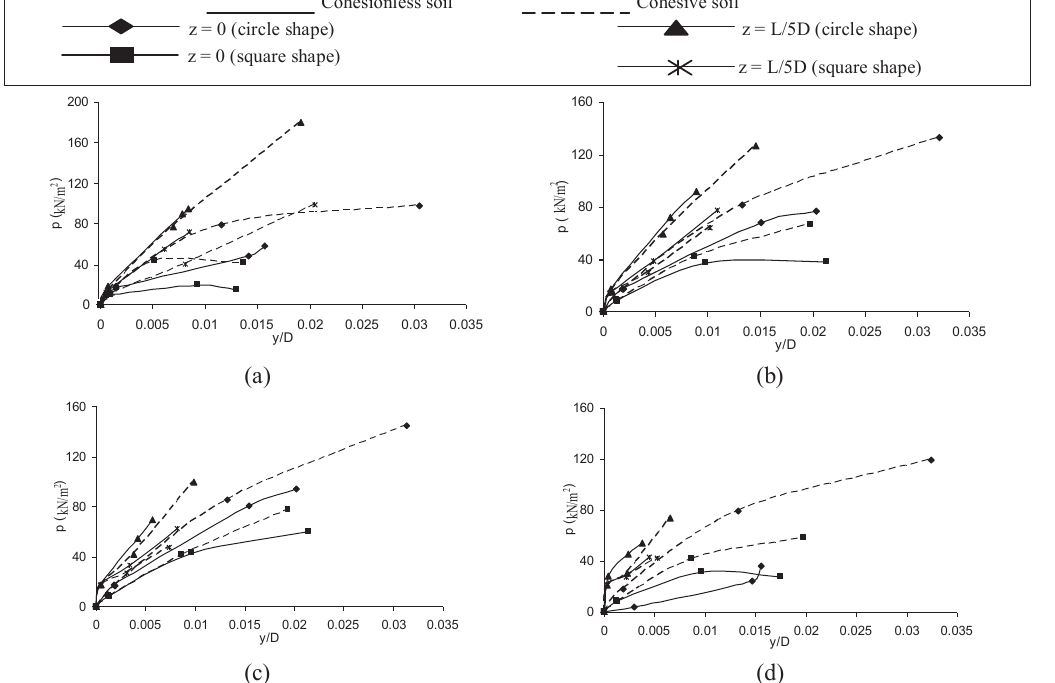
Figure 9: p–y curves predicted under the effect of pile shape and pile slenderness ratio of pile embedded on both cohesionless and cohesive soils: (a) L / D = 10, (b) L / D = 15, (c) L / D = 20 and (d) L / D = 25